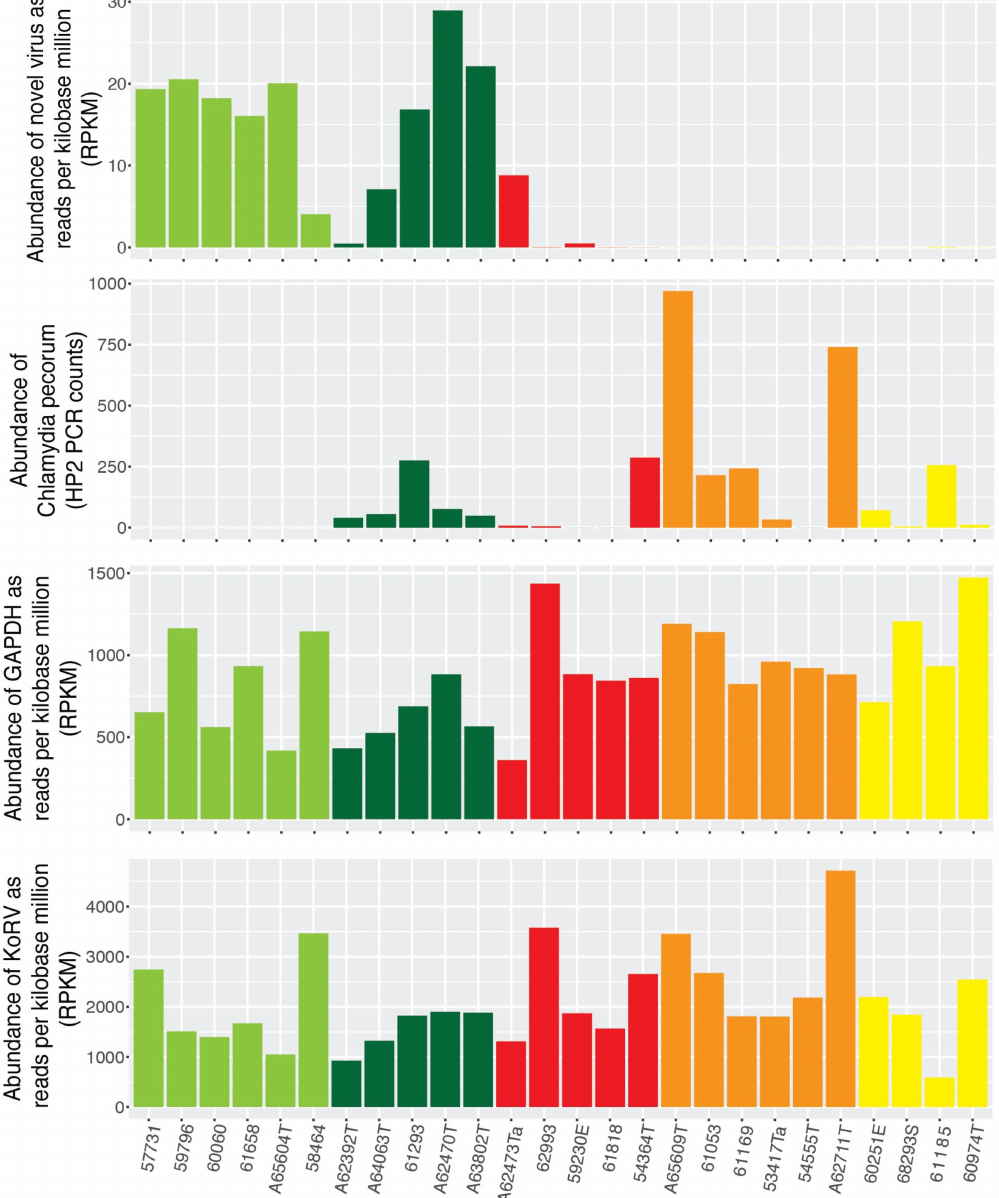
Figure 2. Abundance of Burpengary virus, koala GAPDH, KoRV and C. pecorum . Samples are grouped and colour coded by the individual koalas health status as follows: H1—light green, H2—dark green, G1—red, G2—orange and G3—yellow. The abundance of Burpengary virus, KoRV and GAPDH are measured in reads per kilobase million based on fastq reads, while the abundance of C. pecorum was measured by